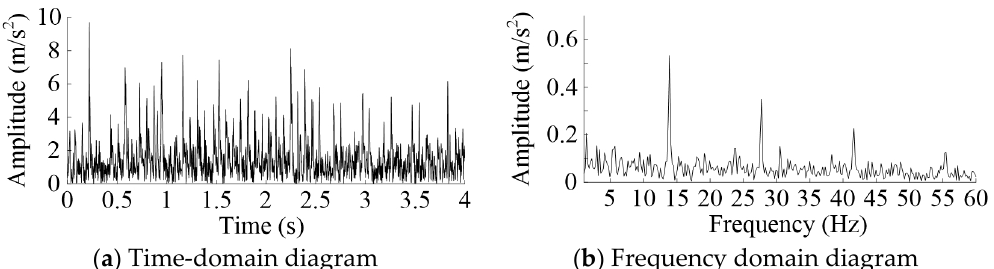
Figure 14. Hilbert envelop demodulation analysis of the filtered vibration acceleration signals. The vibration signals of all test groups were filtered and analyzed by Hilbert envelope demodulation analysis. The peak frequency and amplitude are shown in Table 4. With the increase of frequency doubling of vibration frequency, the amplitude of the vibration acceleration signal decreased gradually, and the decreasing rate slowed down. When the pressure angle was 15 degrees, the amplitude corresponding to each peak frequency decreased with the increase of the load mass. At a pressure angle of 25 degrees, the conclusions varied depending on the wheel-tooth ratio. When the wheel-tooth ratio was cos α , the amplitude of each peak frequency increased with the increase of the load mass. When the wheel-tooth ratio was 1, the result was reversed. The former was significantly lower than the latter at the same load mass and pressure angle. When the wheel-tooth ratio and the load mass were unchanged, the amplitude of each peak frequency of vibration acceleration decreased with the increase of pressure Table 4. Peak amplitude-frequency table of the toothed rails.